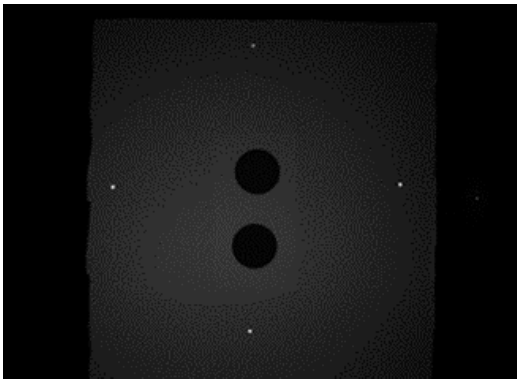
Figure 4. Image of the object and projected laser spots taken from system’s the camera.